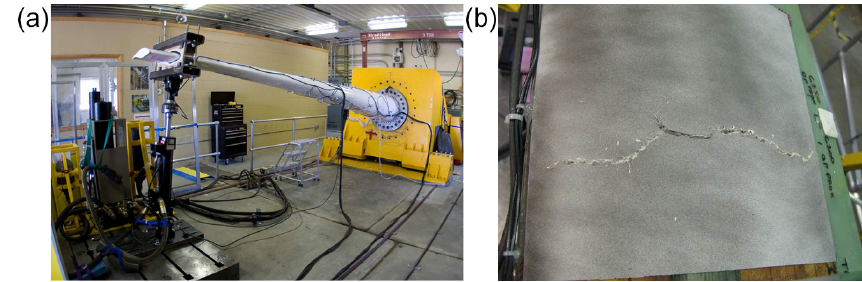
Figure 20. Actual subscale blade test (a) with final failure at flaw location (b)